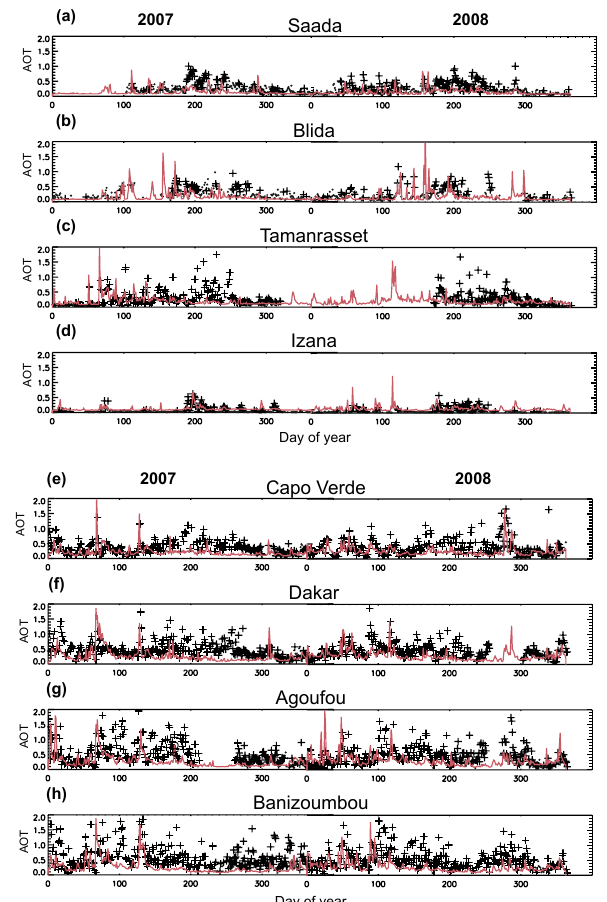
Fig. 5. Time series of daily modelled dust optical thickness (red line) and AOT measurements at 440nm from AERONET at the sta- tions Tamanrasset (22.8 ◦ N, 5.5 ◦ E), Blida (36.5 ◦ N, 2.9 ◦ E), Saada (31.6 ◦ N, 8.2 ◦ W), Dakar (14.4 ◦ N, 17.0 ◦ W), that are located in the vicinity of the Saharan desert, Banizoumbou (13.5 ◦ N, 3.7 ◦ E) and Agoufou (15.3 ◦ N, 1.5 ◦ W) in the Sahel, and the island locations Cape Verde (16.7 ◦ N, 22.9 ◦ W) and Izana (28.3 ◦ N, 16.5 ◦ W) (black plus signs) for 2007 and 2008. The black dots represent AOT mea- surements for ˚ Angstrom parameters larger than 0.7 where dust AOT is not